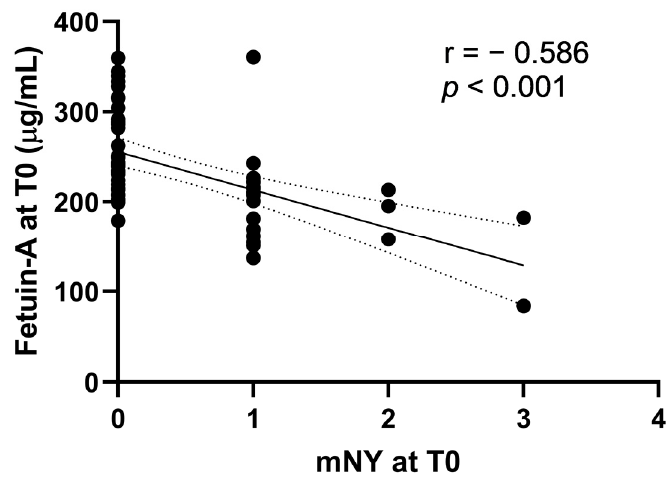
Figure 2. Scatterplot: Association of Fetuin-A at T0 and of mNY at T0. mNY at T24 correlated significantly with fetuin-A levels at T24 ( p < 0.001) (Figure 3) and BASDAI at T24 ( p = 0.07) and, as expected, with SPARCC spine ( p = 0.07) and SPARCC SIJ ( p = 0.01) (Table S6). Multiple linear regression analysis was run to determine what factors at T24 were significantly associated with mNY at T24. Variables included in the analysis were BASDAI and fetuin-A at T24. No variable was excluded because of collinearity. The regression model was statistically significant, R 2 = 0.16, F (2) = 3.51; p = 0.40 (Table 3). Table 3. Multivariate analysis of factors associated with mNY score at T0 and at T24, results of multiple regression analysis.